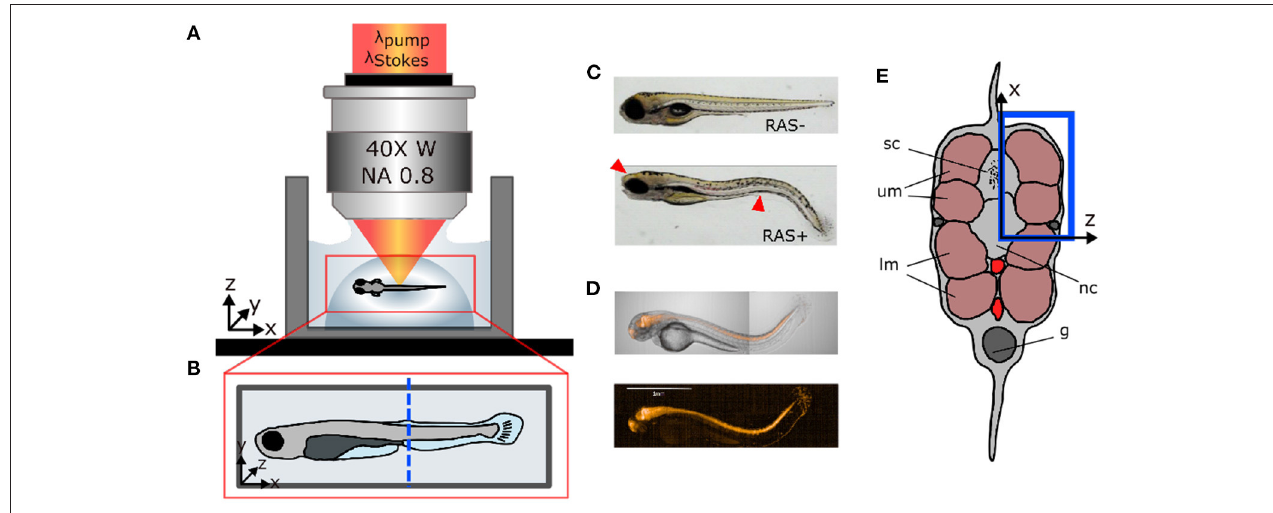
FIGURE 1 | Sample preparation for in vivo imaging. (A) Lateral view of coherent anti-Stokes Raman scattering (CARS) microscope objective showing the fish mounted in agarose gel. (B) Top view of fish mount showing the imaging region of interest (ROI) (blue dashed line). (C) Microscopic white light images of RAS- and RAS+ larvae showing the cancer phenotype (red arrows). (D) mCherry expression at location of RasG12V expression in a 96 hpf larvae. (E) Cross-section of the zebrafish larvae showing the ROI in depth (blue rectangle) with: sc, spinal cord; um, dorsal myotomes; lm, lower myotomes; nc, notochord; g,